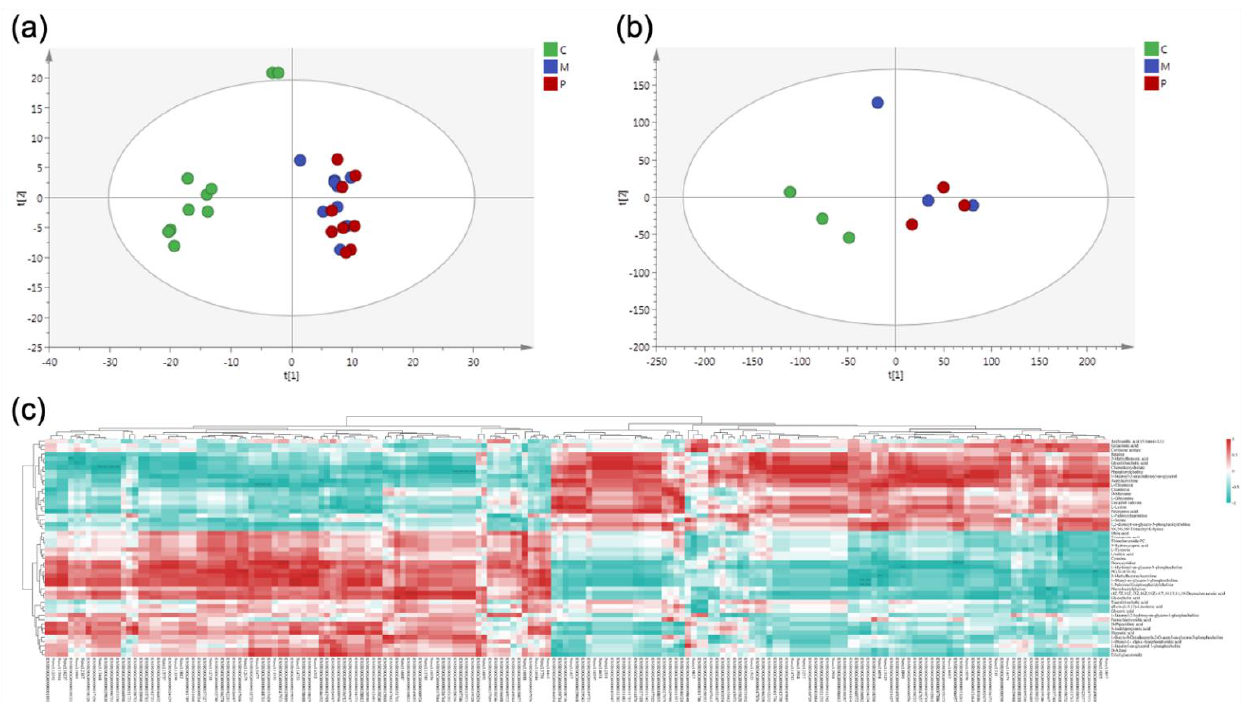
Figure 4. Correlation analysis. ( a ) Metabolomics PCA plot; each point represents one sample. ( b ) Transcriptomics PCA plot. ( c ) Hierarchical cluster heat map for Spearman correlation analysis of differential genes and differential metabolites. Correlation coefficient r is indicated by color. r > 0 indicates positive correlation, represented by red, r < 0 indicates negative correlation, represented by blue, and darker color indicates stronger correlation.